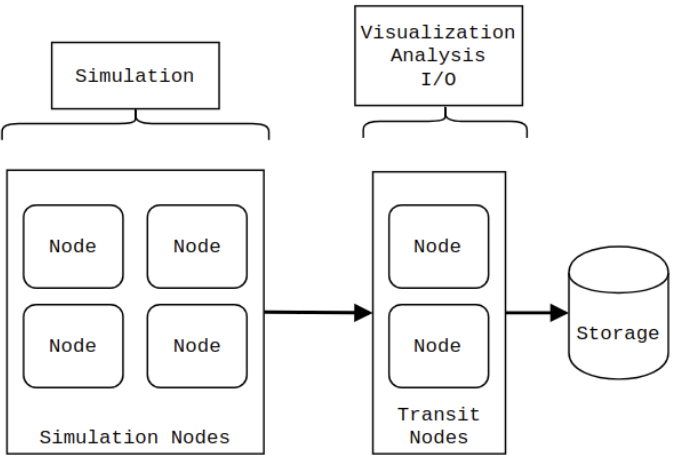
Figure 1. In-transit co-processing. The simulation is performed on one set of nodes, whereas visualization, analysis, and I/O operations are performed on a different set (transit